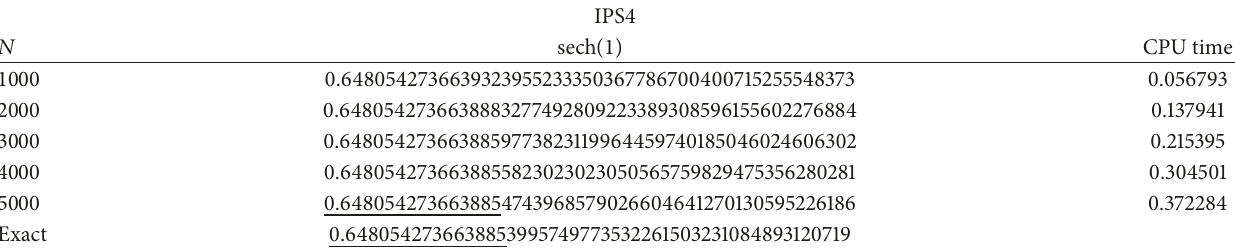
Table 2: IPS4 sech (𝑥) solution of the NLSE, (29), computed at 𝑥 = 1 .